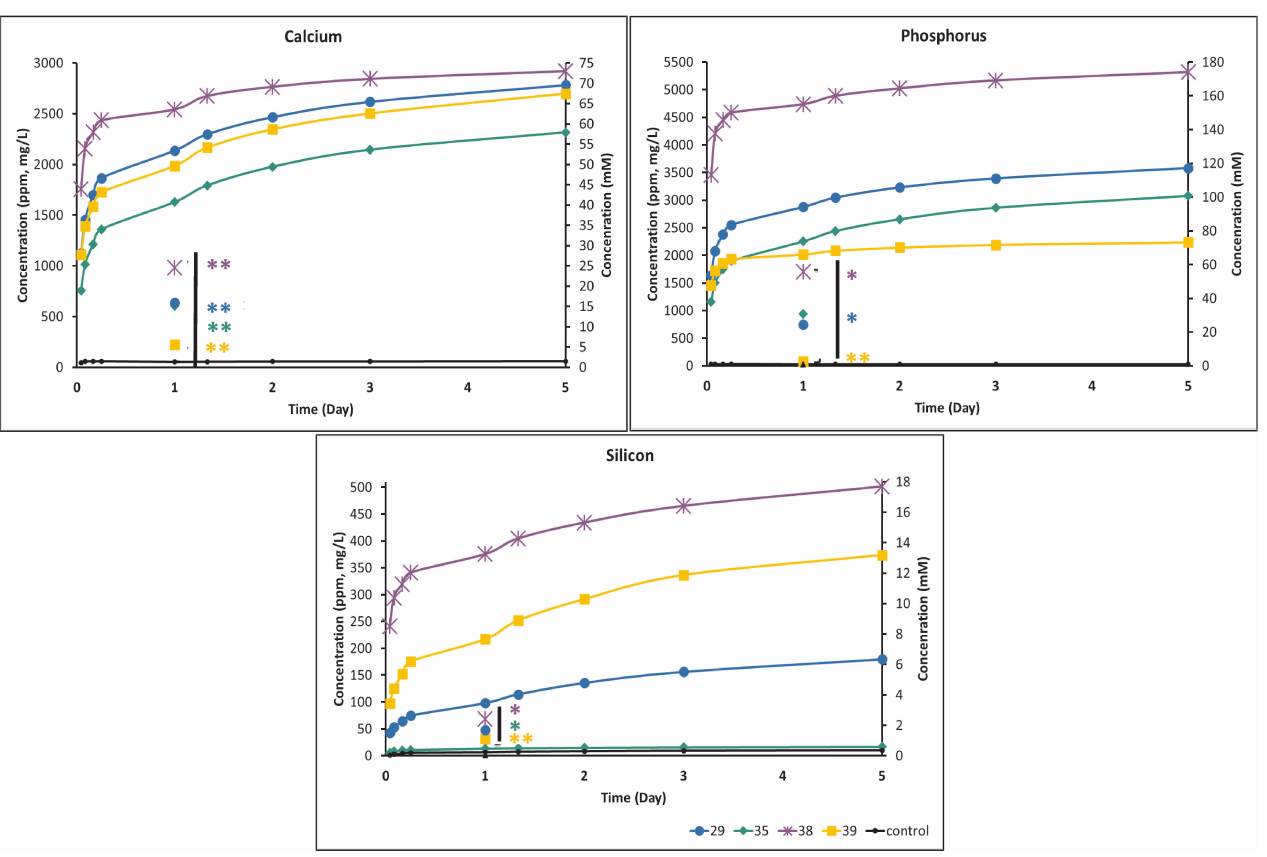
Figure 5. Effect of media replenishment on ion release profiles, for a broad formulation range. Ion release profile was measured in dynamic (lines) and static (single data points at 24 h) mode only for samples #29, #34, #38, and #39, and control for ( A ) calcium, ( B ) phosphorus, and ( C ) silicon. These samples were selected to represent the range of compositions and viability. Single data points at 24 h represent “static” data in accordance with ISO 10993 (media collected only once after 24 h immersion). Sample dimensions were 8.9 mm × 4.5 mm, cured to the initial setting time before immersion. **, and *, § indicates p < 0.01 and 0.05, respectively, for comparisons made between the cumulative release of each respective static or dynamic group at 1 day (*, Games − Howell); and between all groups and the highest eluting sample (#38, §, Dunnets post